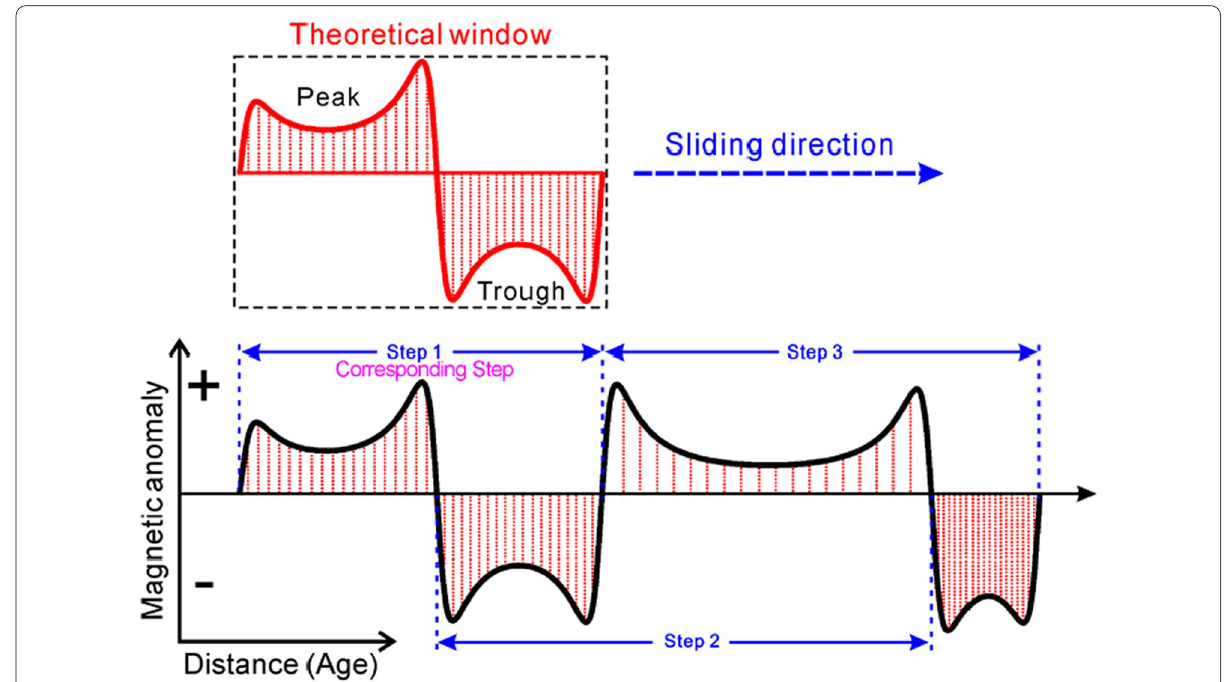
Fig. 2 The schematic diagram of the sliding window technique